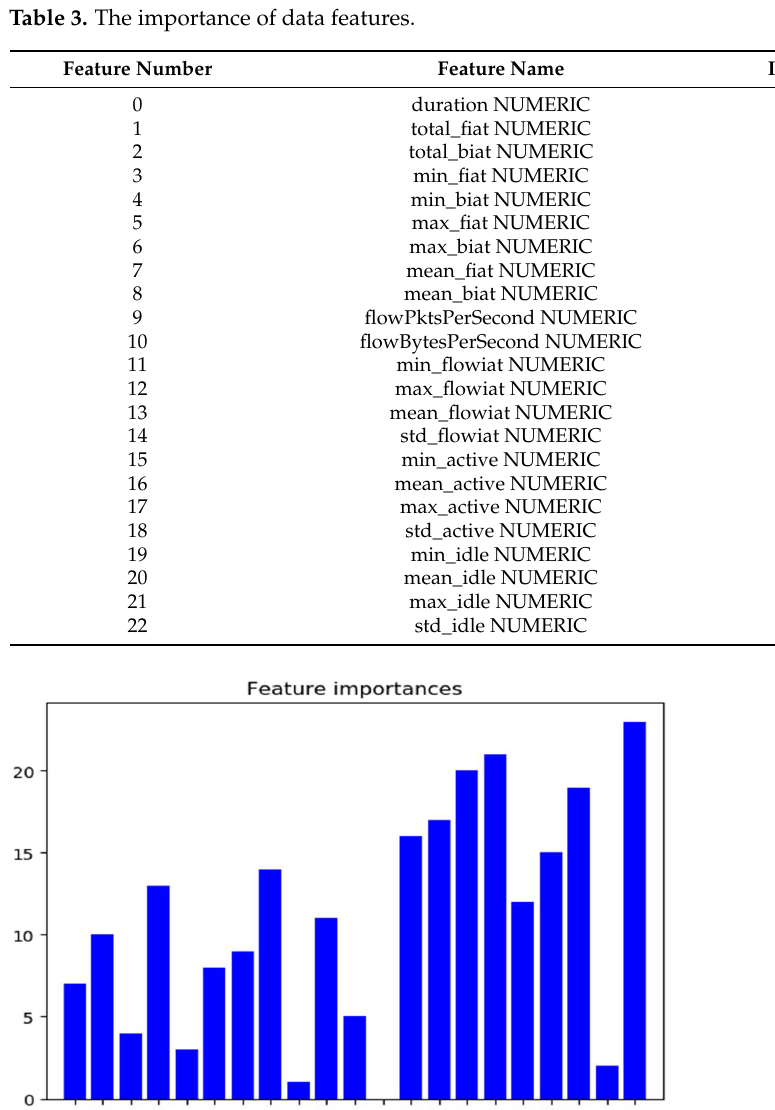
Figure 7. Importance of data features.